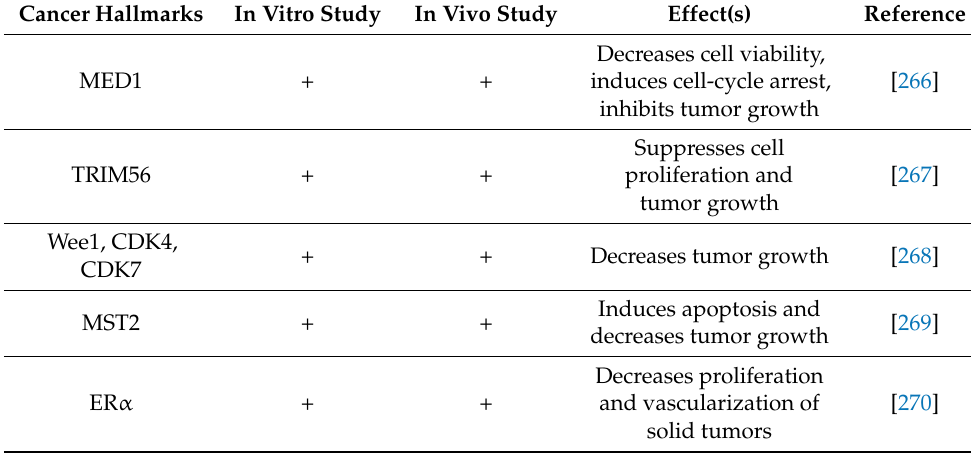
Table 2. SiRNAs linked with anti-estrogen therapy resistance of ER+ BC. Cancer